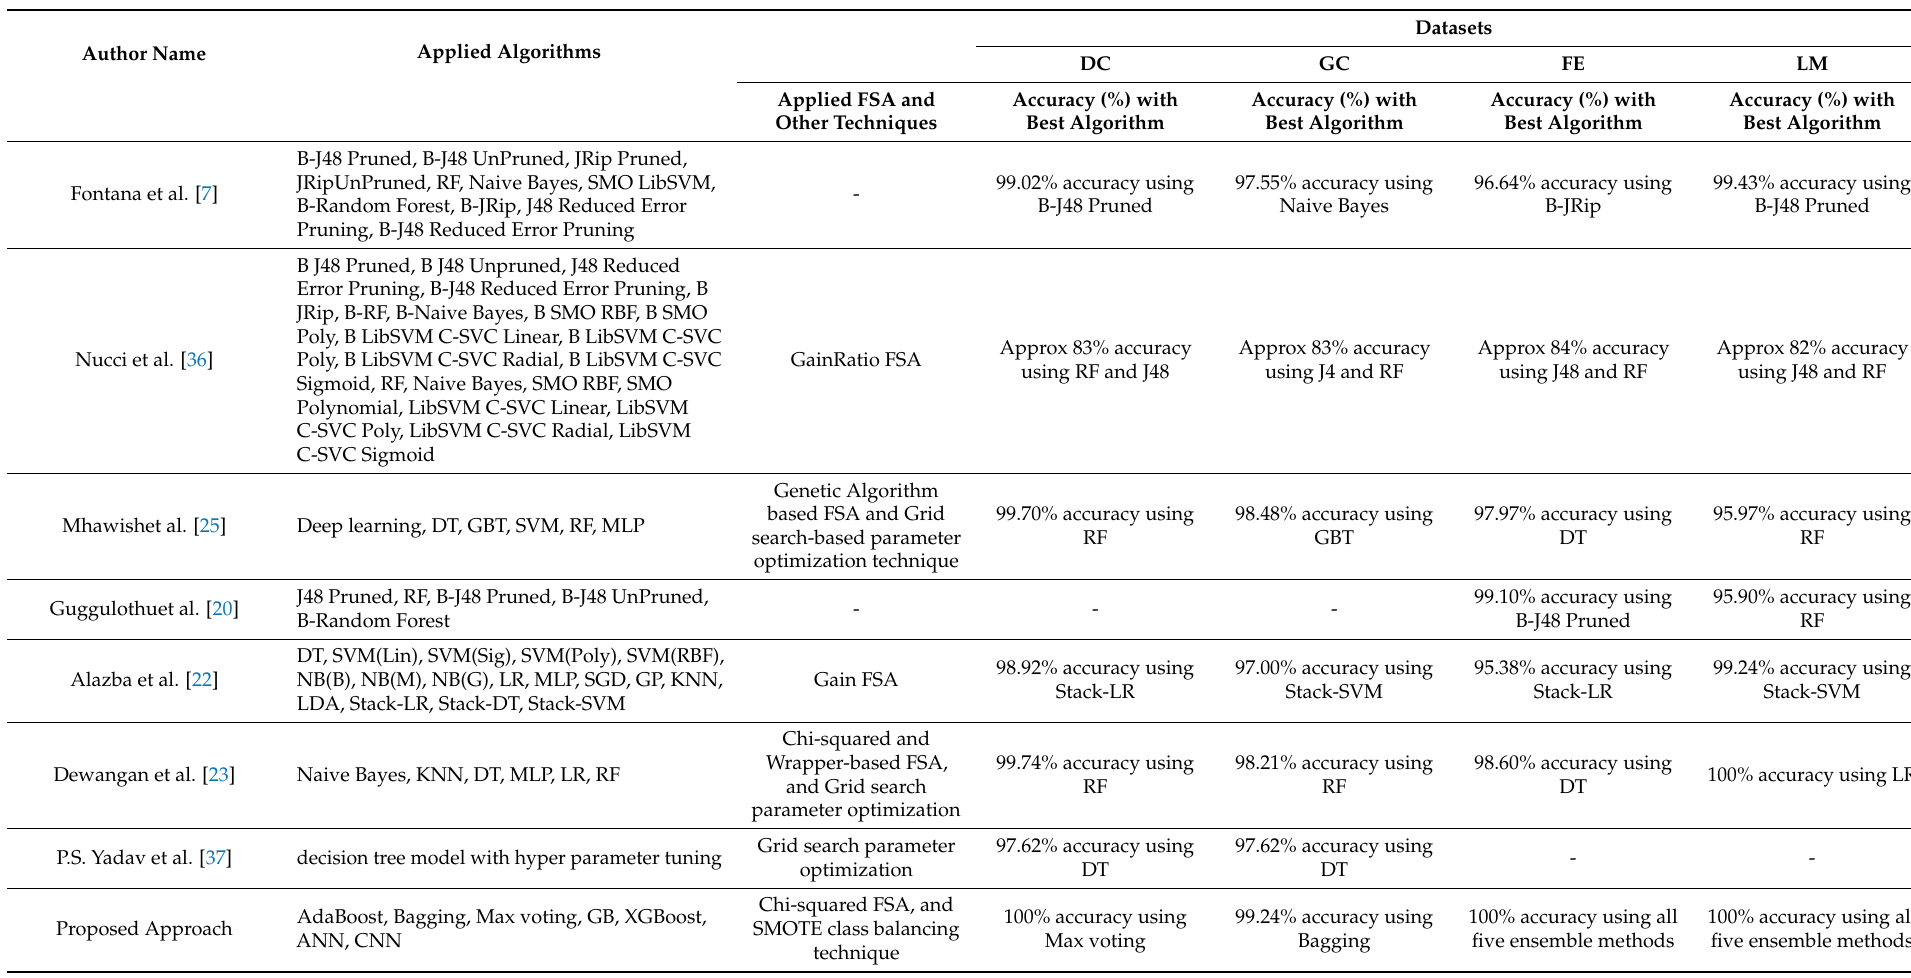
Table 16. Result and all model comparison of our approach with other correlated